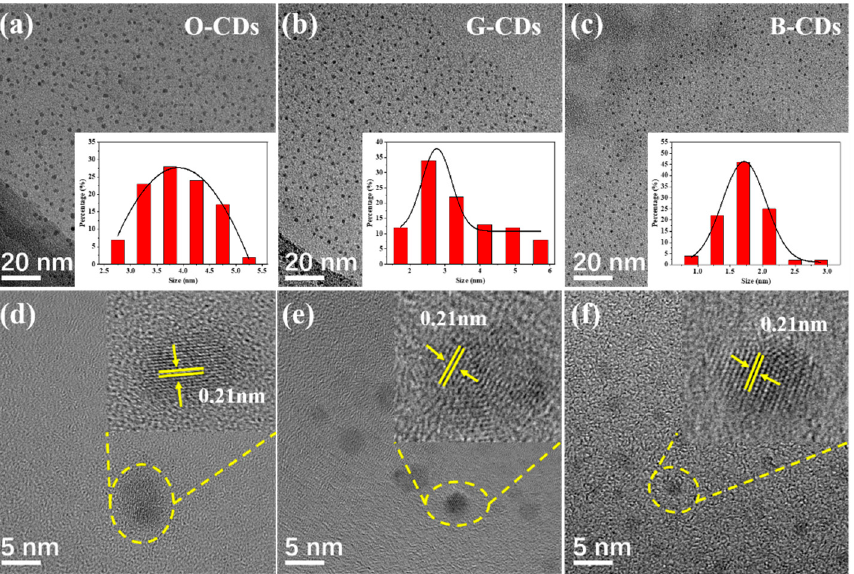
Figure 2. ( a – c ) TEM images of O-CDs, G-CDs and B-CDs. Insets: particle size distribution. ( d – f ) HRTEM images of O-CDs, G-CDs and B-CDs.